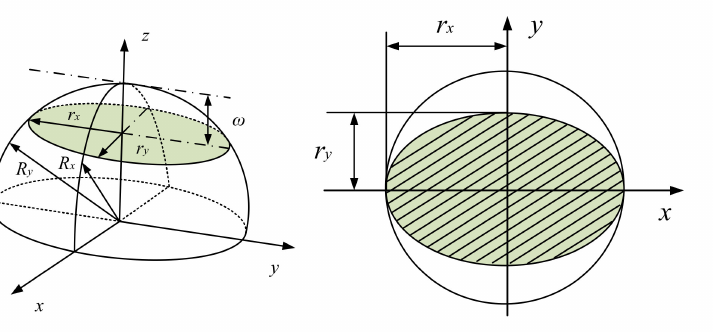
Figure 6. Comparison of the contact area between spherical asperity and elliptical